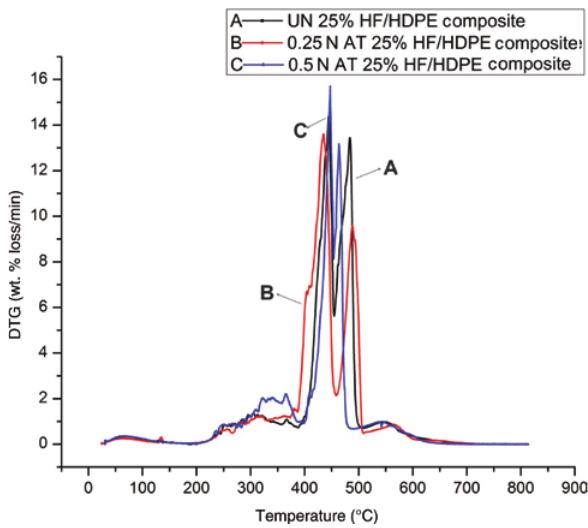
Figure 10: DTG thermograms of untreated and treated 25% HF/HDPE